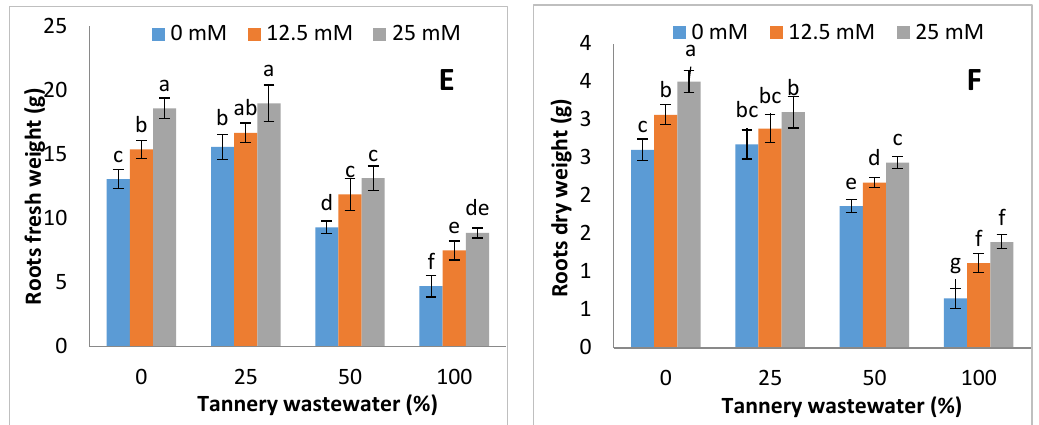
Figure 2. Graphs showing effect of foliar spray of zinc chelated lysine (0, 12.5, 25 mM) on fresh and dry biomass of leaves ( A,B ), stem ( C,D ) and roots ( E,F ) of maize plants growing under 0%, 25%, 50%, 100% concentration of tannery wastewater. Values are means of three replicates. Statistical analyses were carried out by ANOVA, followed by Tukey’s Post-Hoc test.